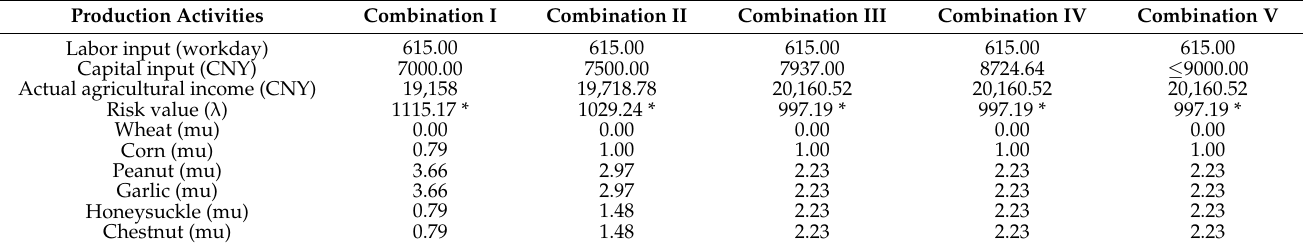
Table 8. Optimization of capital input for I PTPH .